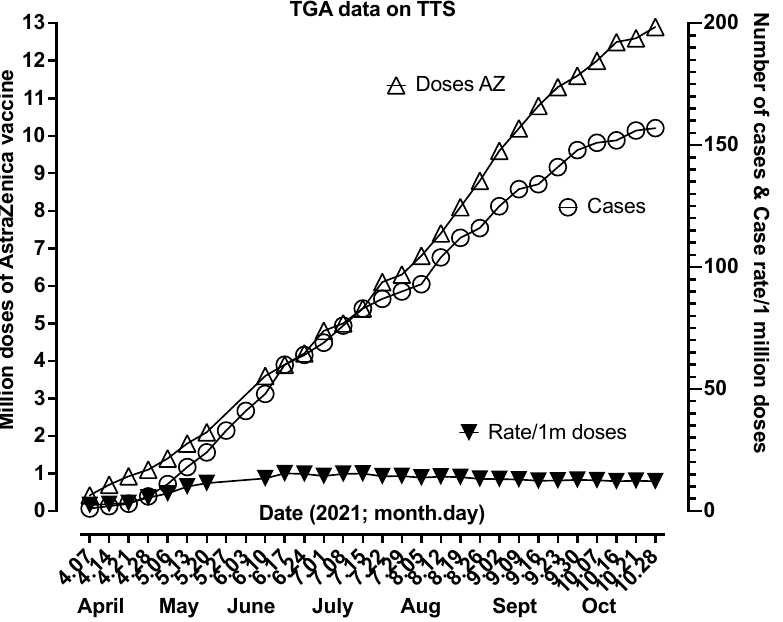
Figure 4. Cases of TTS as reported weekly by the Australian TGA from the first case reported at the beginning of April 2021 until the end of October 2021. The figure shows the cumulative number of AstraZeneca (AZ) doses administered, the cumulative number of TTS cases, and the TTS rate per million AZ doses. From an initial slow case attainment, the rate seemed to stabilize from June to October at around 13–15/million doses. Please see [31] for additional details.